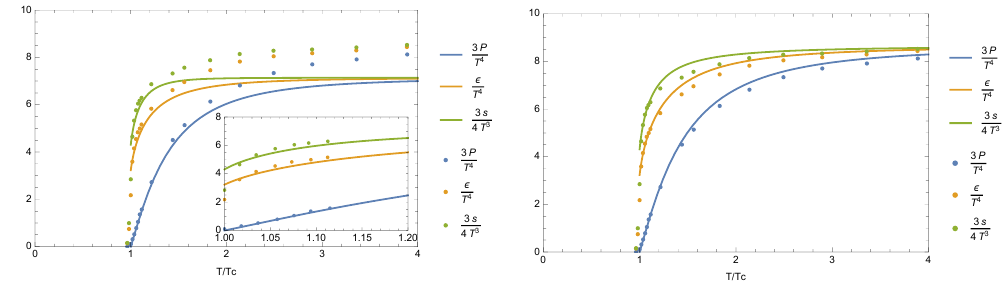
Figure 1 . Fitting the 4-6 PLM to the thermodynamic quantities of SU(4) PYM theory ob- served in the lattice simulations [22], at around the critical temperature ( T deconfinement phase transition of the first order. In the left panel, several thermodynamic quantities are plotted as a function of T/T b = − 2 . 19 and c = 2 . 28 , while those with a 0 = 6 . 36 , a 1 = 0 . 04 , a 2 = − 2 . 68 , a 3 = − 4 . 72 , b = − 2 . 28 and c = 2 . 58 are displayed in the right panel. The LS fit has been worked out only for 1 ≤ T/T (focusing on the criticality regime) in the left panel, as zoomed-in the close-up small window, while in the right panel for 1 ≤ T/T